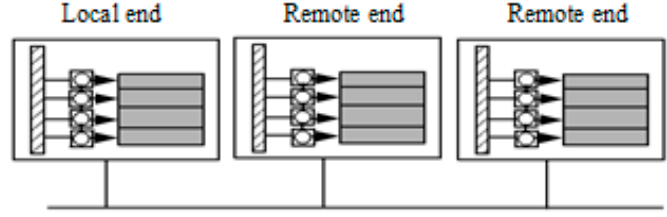
Figure 9. Wide-area fault location method: the local site is where the application request originates and is responsible for coordinating the remote replicas.